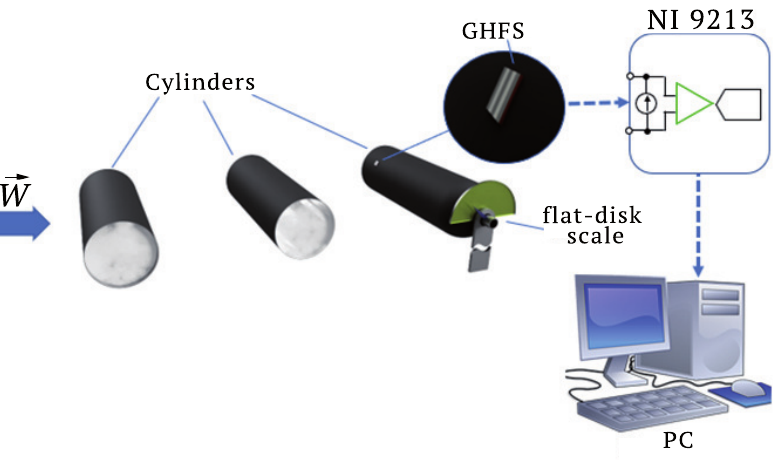
Figure 5. Diagram of gradient heatmetry experimental